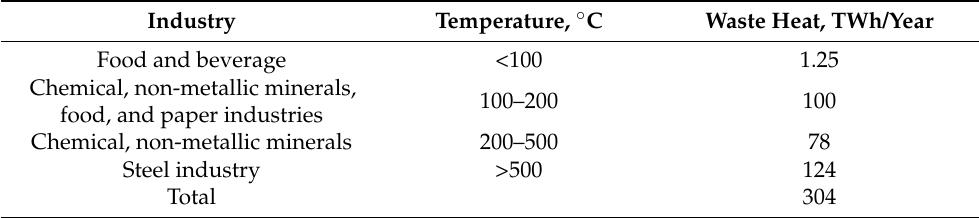
Table 1. Waste heat potential of industrial processes in EU (2015)